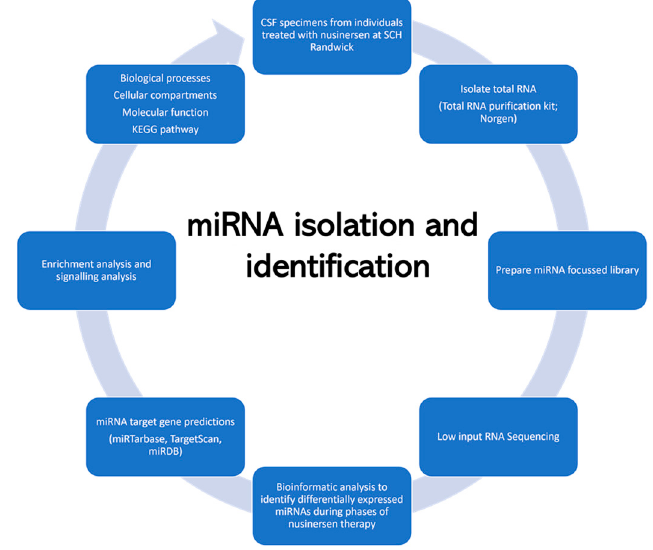
Figure 1. Flowchart of the experimental approach for identification of miRNA in cerebrospinal fluid of children affected with spinal muscular atrophy.